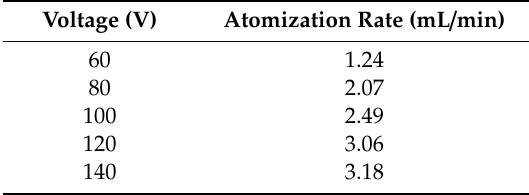
Figure 10. Relationship between the atomization rate and frequency. Table 3. Atomization rates at di ff erent driving voltages, when the driving frequency is 122 kHz. Table 4. Atomization rate of different micro-tapered aperture sizes.